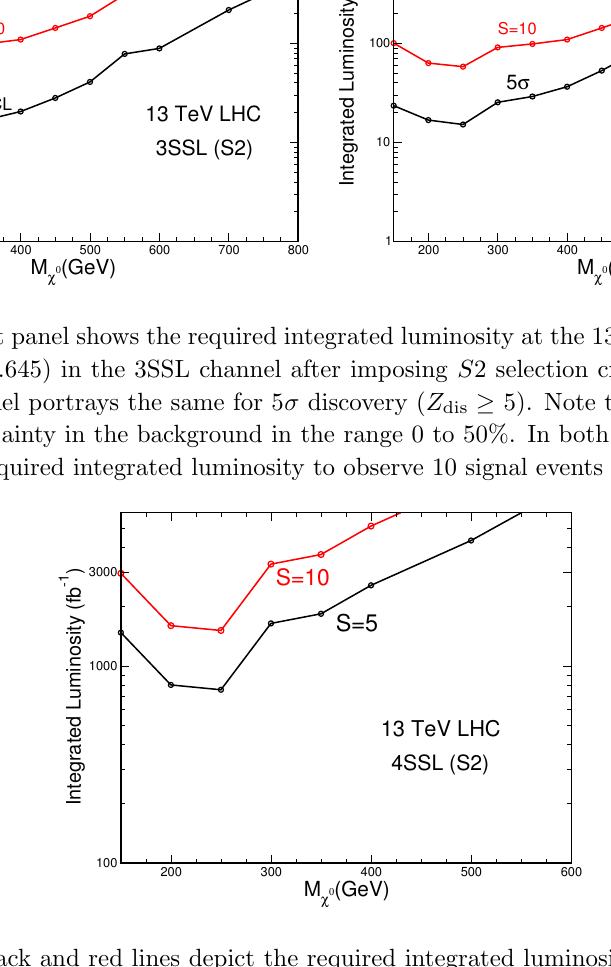
Figure 12 . The black and red lines depict the required integrated luminosity at the 13 TeV LHC to observe at least 5 and 10 signal events respectively in the 4SSL channel after imposing the S 2 selection criteria as a function of the neutral state mass ( M (cid:31) 0